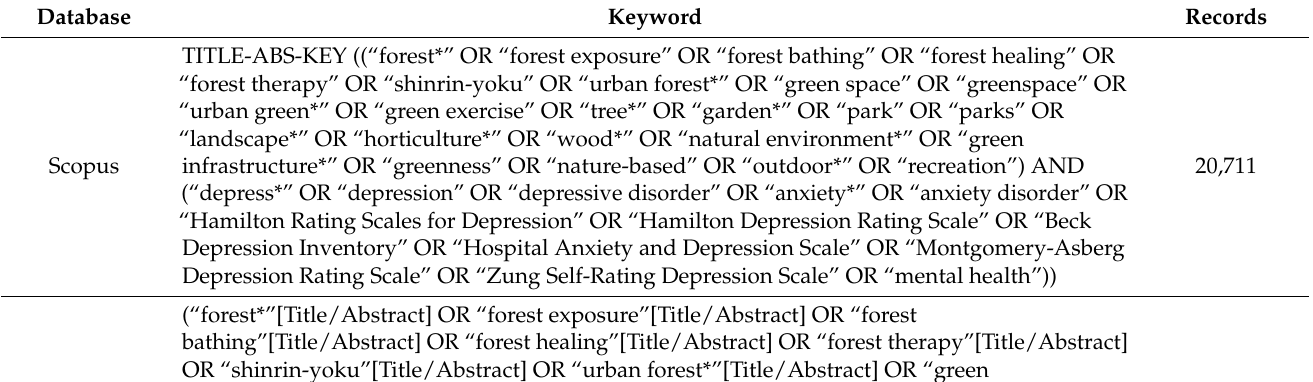
Table A1. Search terms used in each